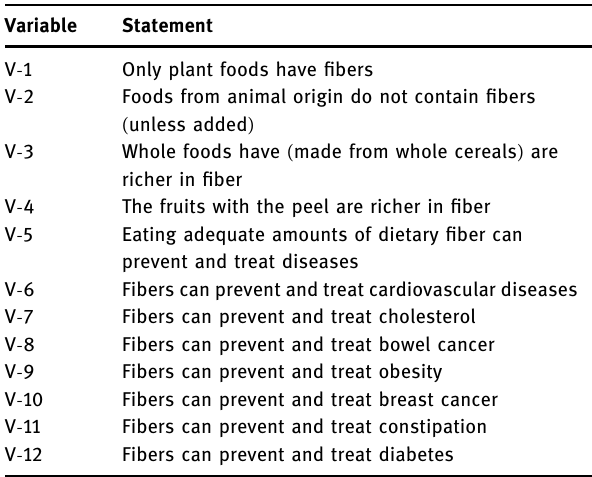
Table 1: Statements relative to knowledge about dietary fi bre